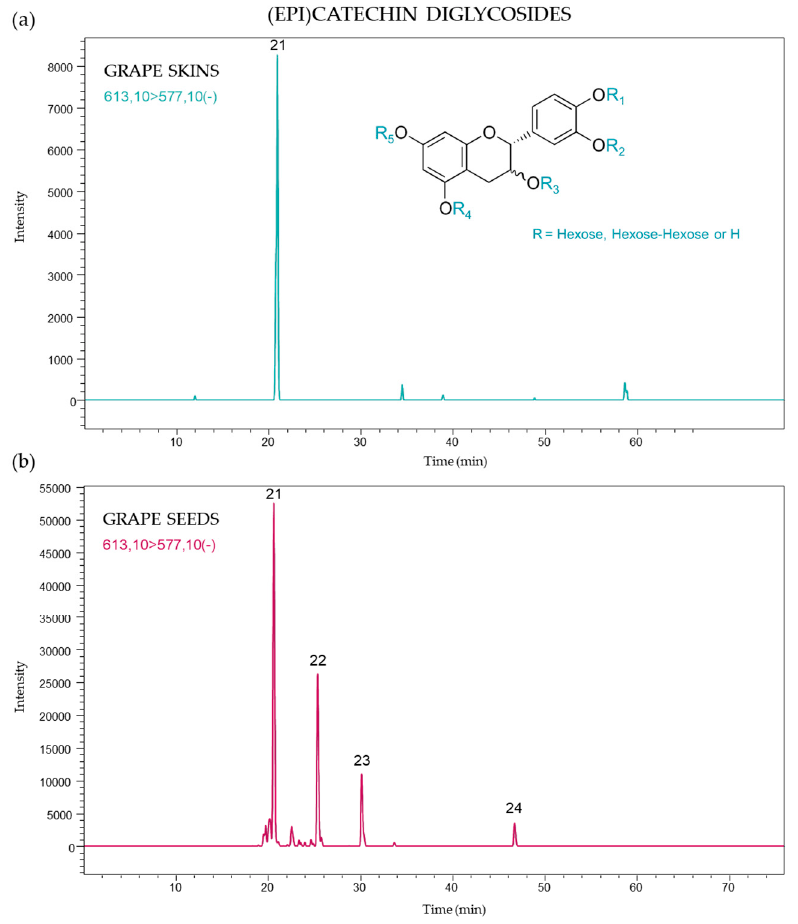
Figure 6. (Epi)catechin diglycoside profile of ( a ) skins and ( b ) seeds from Vitis vinifera grapes using MRM [613 → 577].